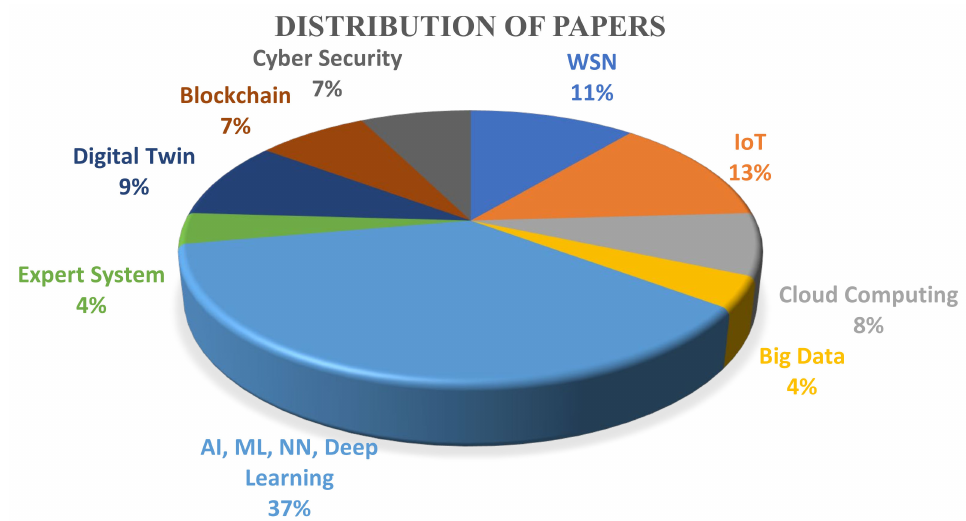
Figure 2. Bar Chart to show the percentage of technologies in the